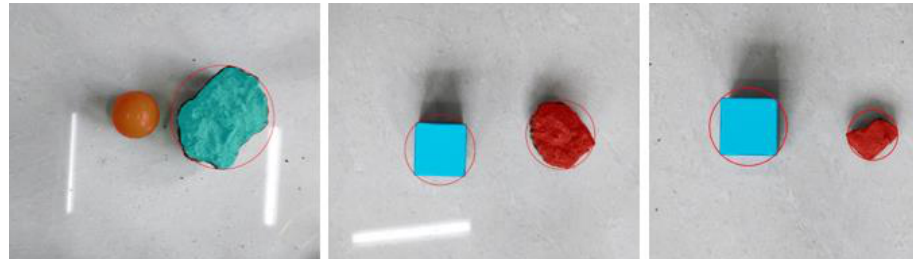
10 of 18 Table 3. Evaluation of training results. Training parameters